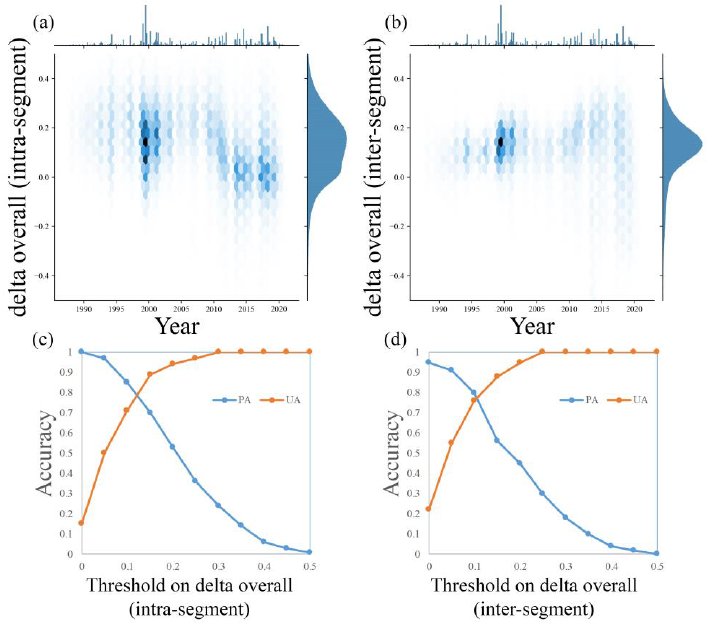
Figure 8. ( a ) The segment distribution of intra-segment delta overall over start time; ( b ) the segment distribution of inter-segment delta overall over start time; ( c ) sensitivity analysis over threshold for intra-segment delta overall; ( d ) sensitivity analysis over threshold for inter-segment delta overall.